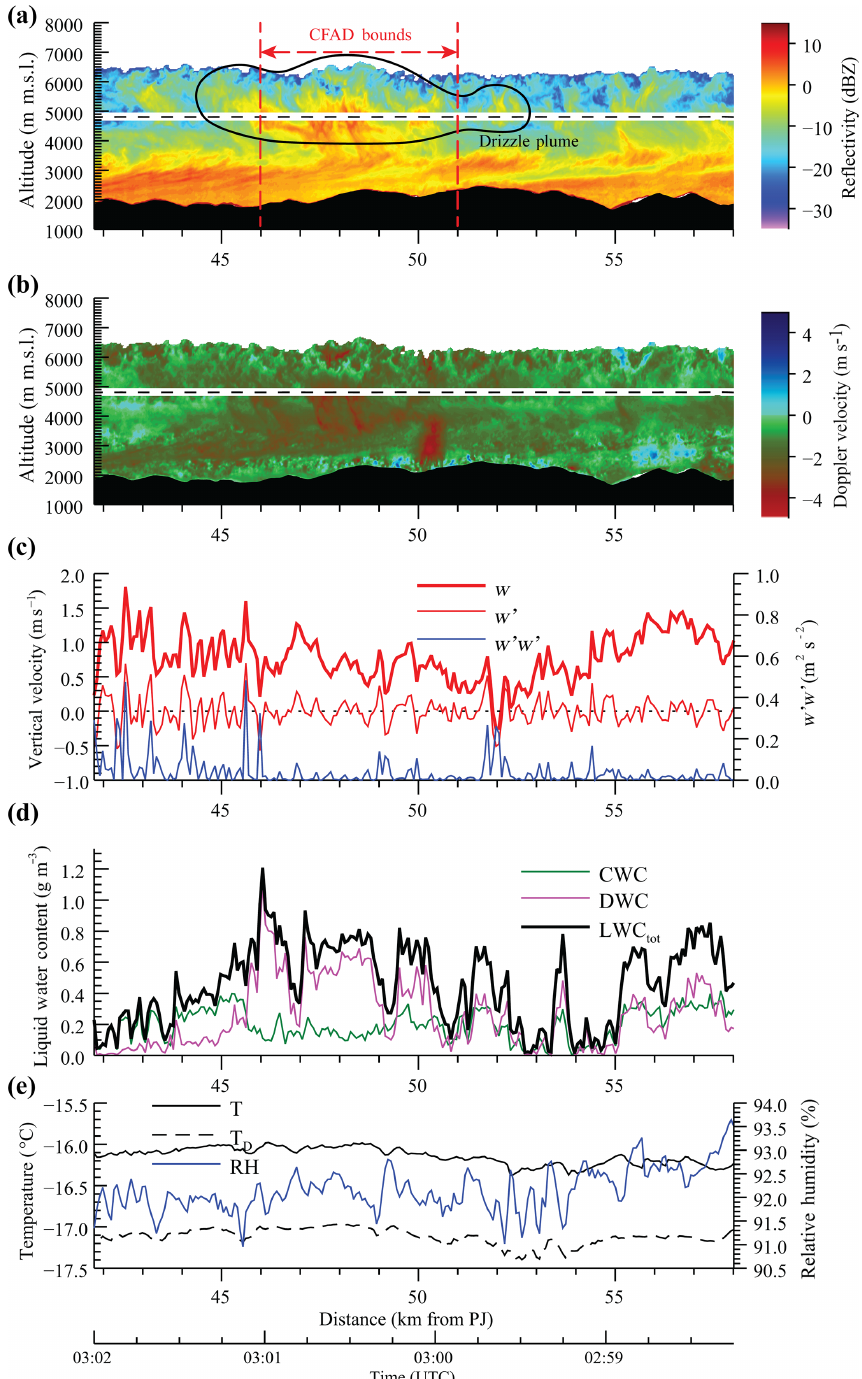
Figure 10. Detailed radar and in situ measurements for the drizzling portion of leg 2. Spatiotemporal vertical cross sections of radar reflectiv- ity are shown in (a) and vertical Doppler velocity is shown in (b) . Panels (c) through (e) are derived from flight-level in situ measurements and show (c) vertical air velocity ( w ), computed perturbation vertical velocity ( w (cid:48) ), and the variance of the perturbation vertical velocity ( w (cid:48) w (cid:48) ); (d) liquid water content derived from cloud droplets (CWC), drizzle drops (DWC), and both combined (LWC tot ); and (e) temperature ( T ), dew point ( T D ), and relative humidity (RH). The CFAD bounds shown in (a) correspond to Fig. 12d–f. Perturbation vertical velocities in (c) were calculated as described in Fig.